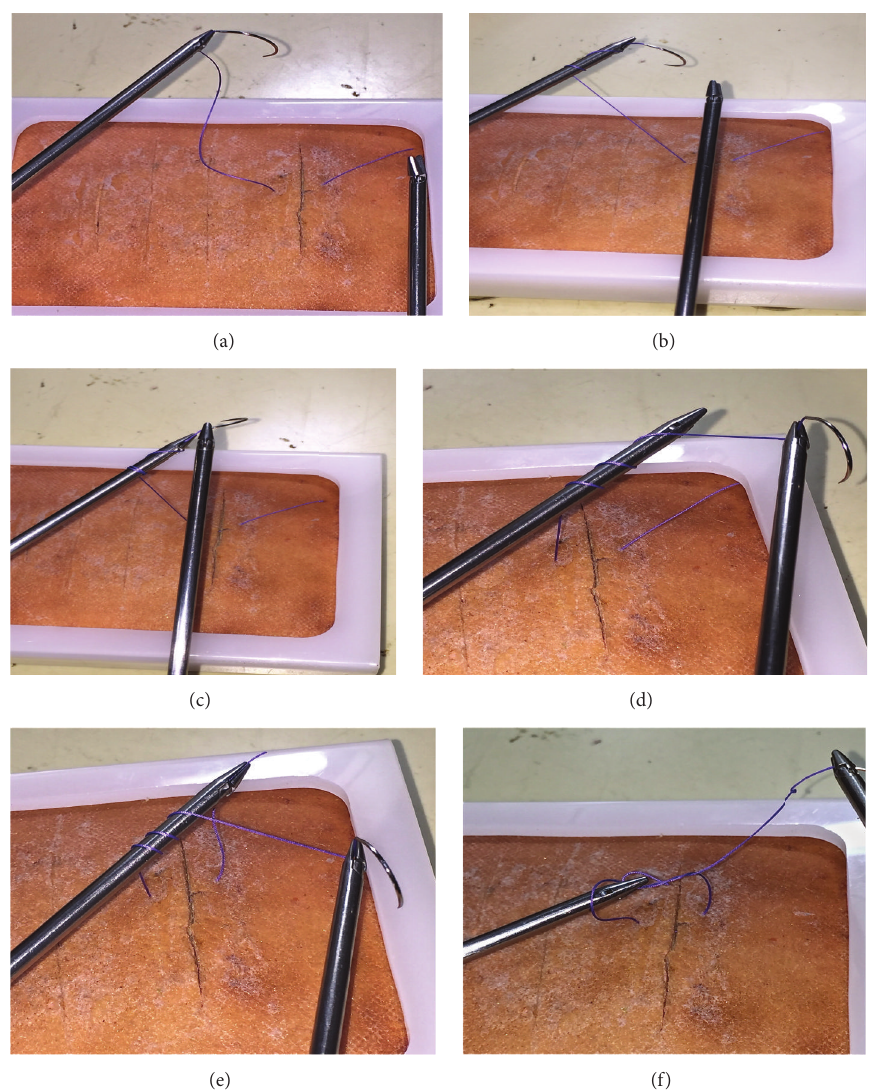
Figure 2: (a) (Step 1 ) Holding the suture material near the needle by left hand needle driver. (b) (Step 2 ) Winding of suture around the left hand needle driver. (c) (Step 3 ) Right hand needle driver receiving the needle from the left hand needle driver. (d) (Step 4 ) Right hand needle driver maintaining the wind on left needle driver. (e) (Step 5 ) Left hand needle driver catching the tail end of suture. (f) (Step 6 ) First throw of knot completed by pulling the tail end of